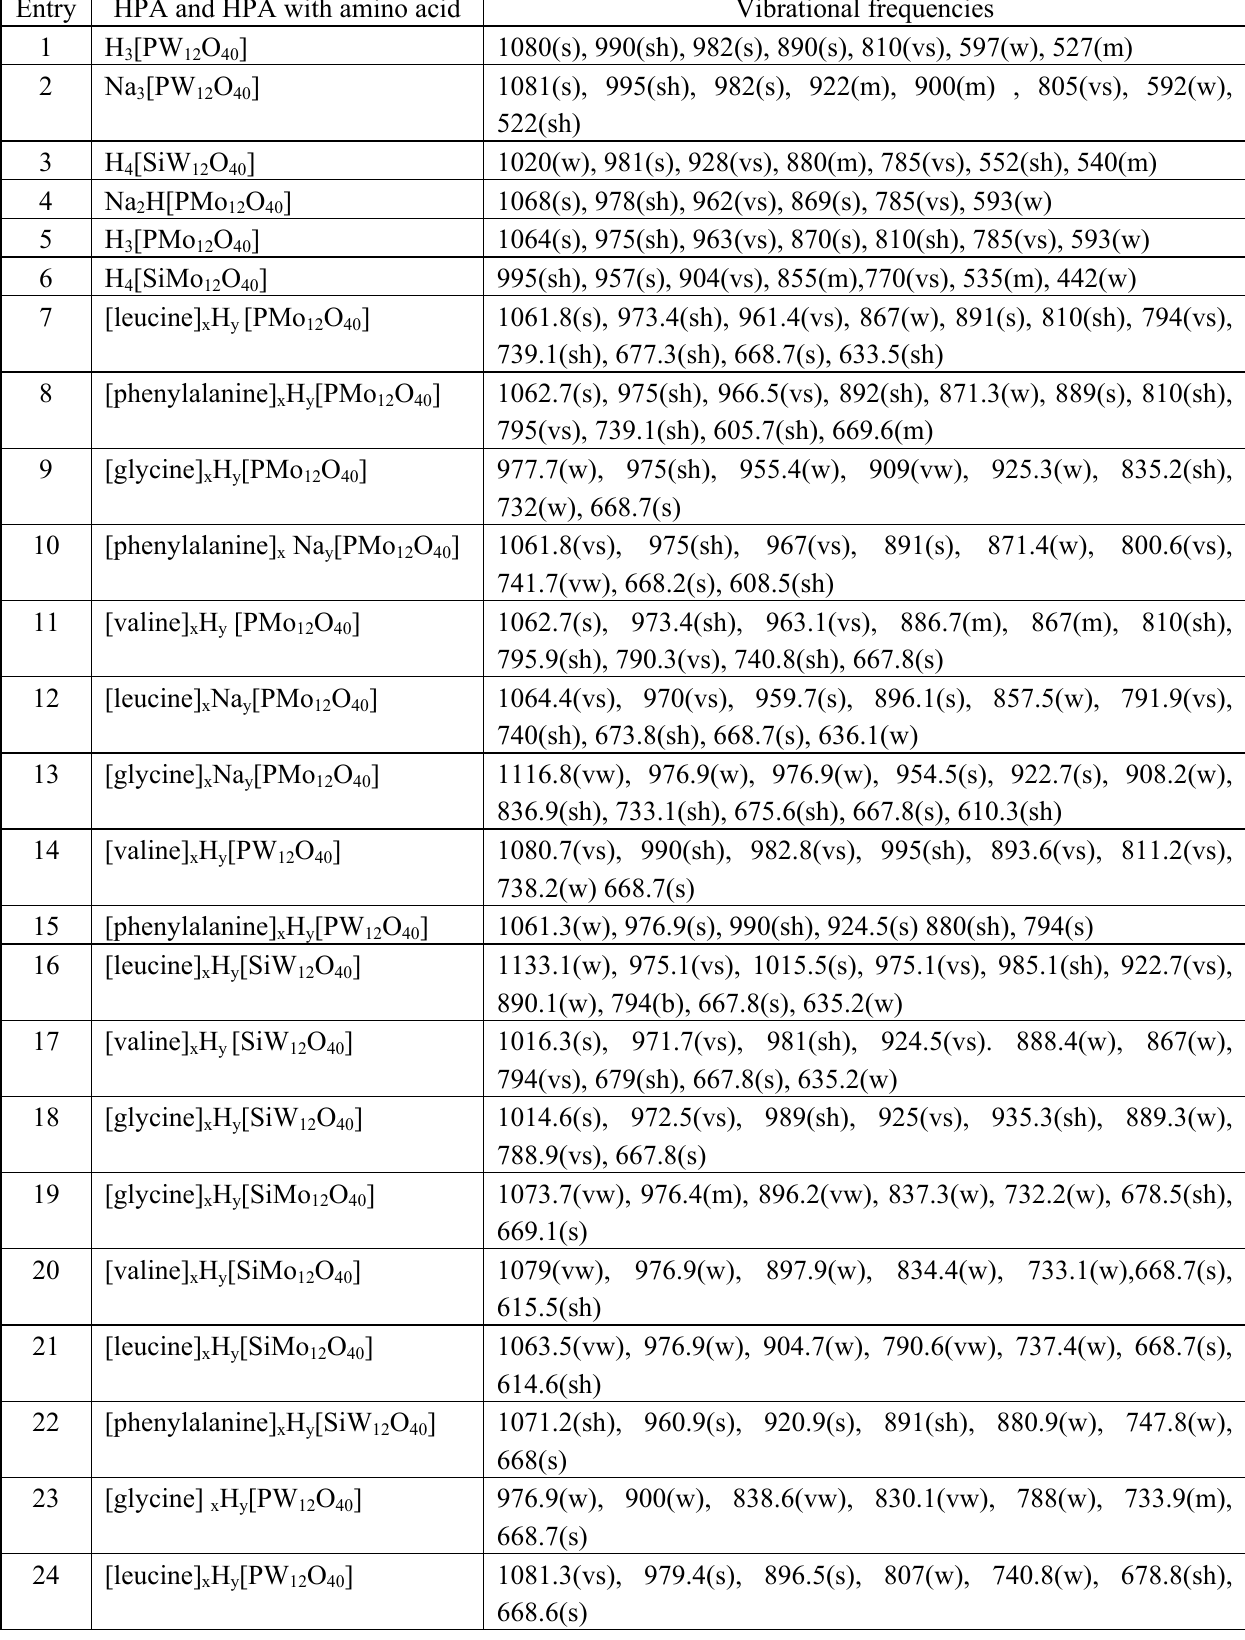
Table 1. Assignments in the vibration spectra of Keggin HPAs with amino acids as counterions. Entry HPA and HPA with amino acid Vibrational